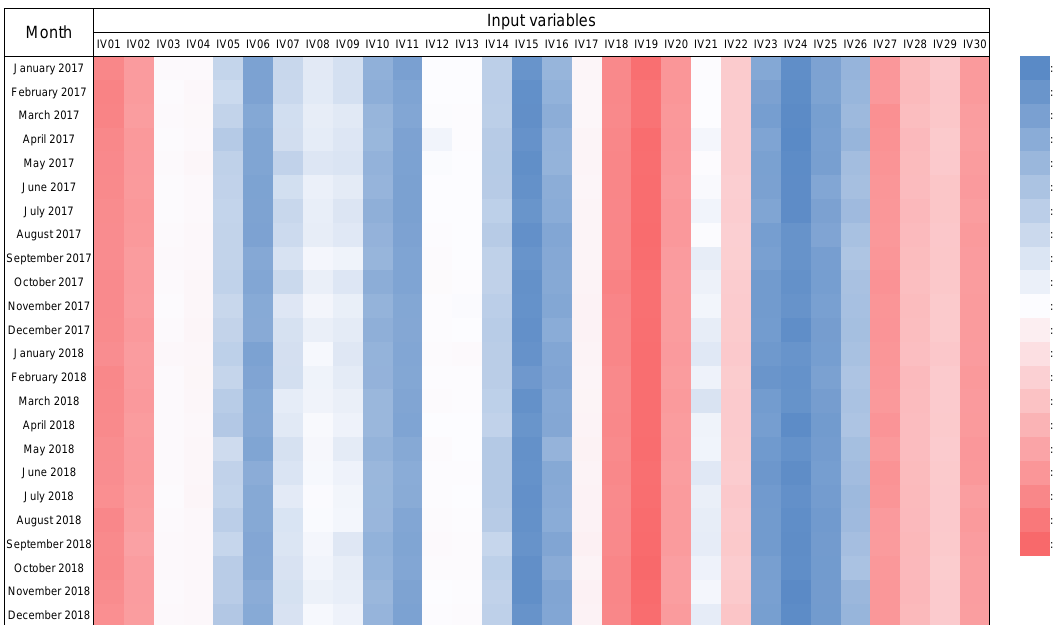
Figure 14. Result of feature importance via time-series cross-validation using the input variables in Table 2 for Ildo-1. A cooler color indicates a lower feature importance value, whereas a warmer color indicates a higher feature importance value.